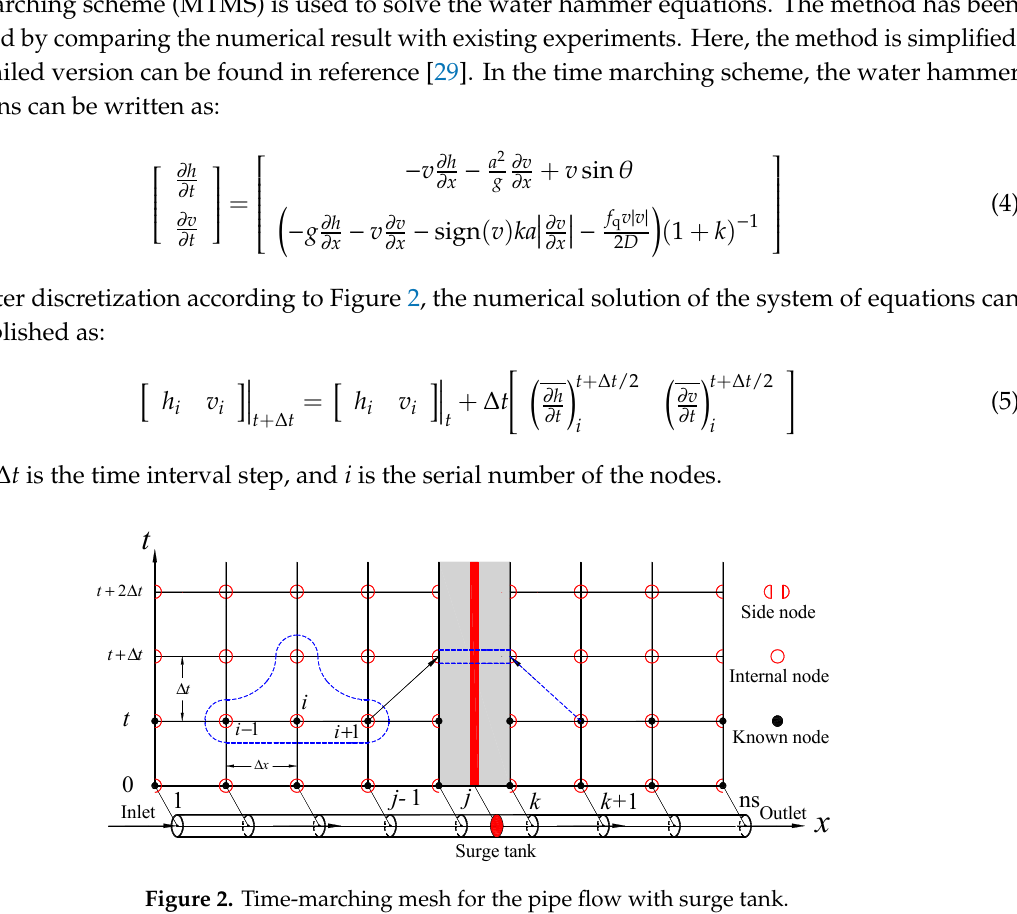
Figure 2. Time-marching mesh for the pipe flow with surge tank.